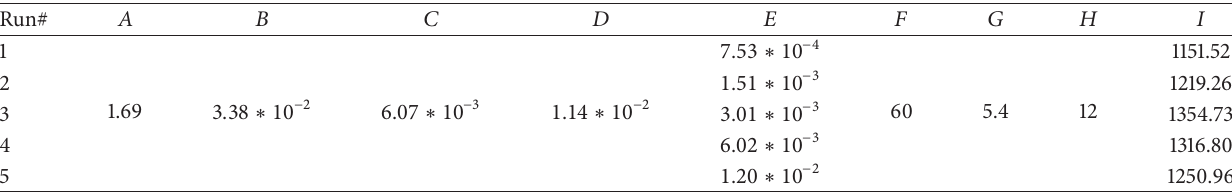
Table 13: Reactions conditions with different silica concentrations.